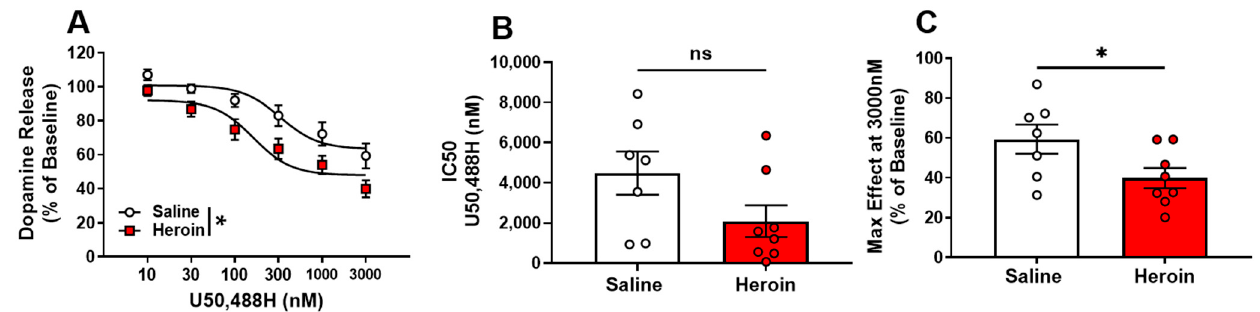
Figure 4. Presynaptic KOR activity on NAc dopamine terminals is increased by heroin self-administration. Selective kappa-opioid receptor agonist U50,488H ( A ) decreased percent baseline dopamine release in heroin exposed rats with ( B ) no significant difference in IC50 between saline exposed and heroin exposed rats, but ( C ) significant decreases in the U50,488H maximal effect in exposed rats. * p < 0.05; ns: not significant.